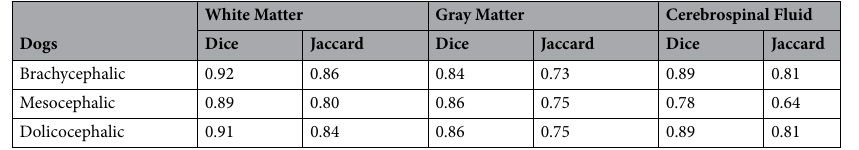
Table 6. Brain tissues segmentation performed by K -Means clustering on brains skull-stripped by VIBE. Three dogs with three different cranial conformations (brachycephalic, mesocephalic, dolichocephalic) are